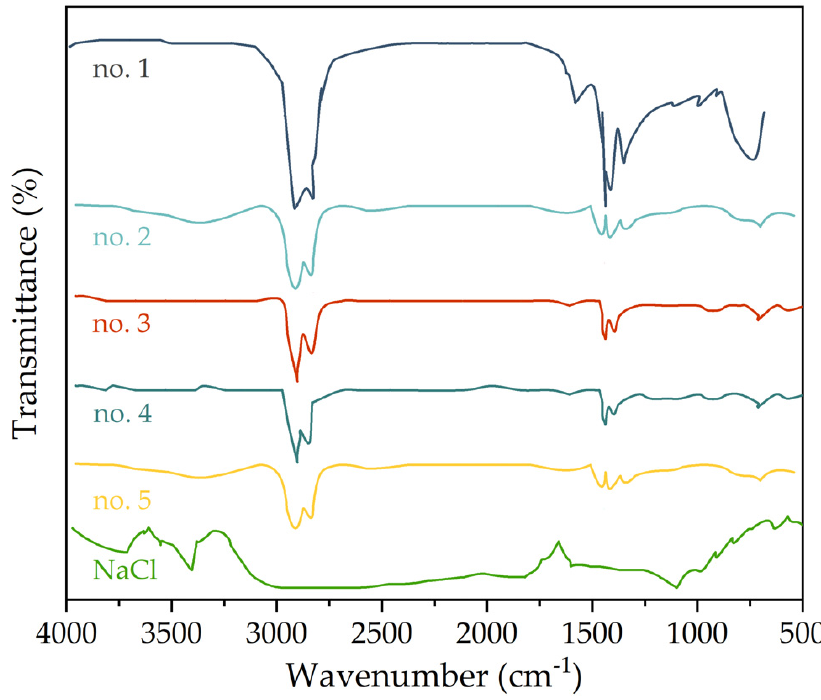
Figure 9. The FTIR results of asphalt with different chloride salt concentrations.